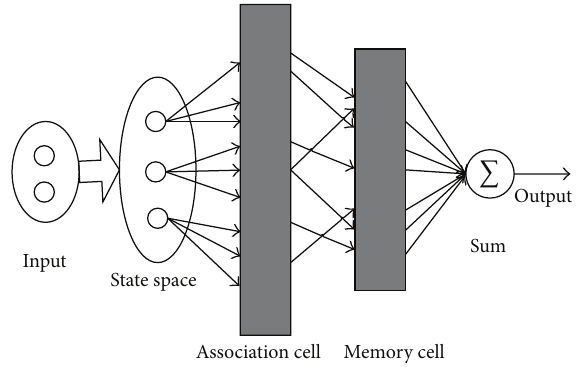
Figure 3: Structure of CMAC neural